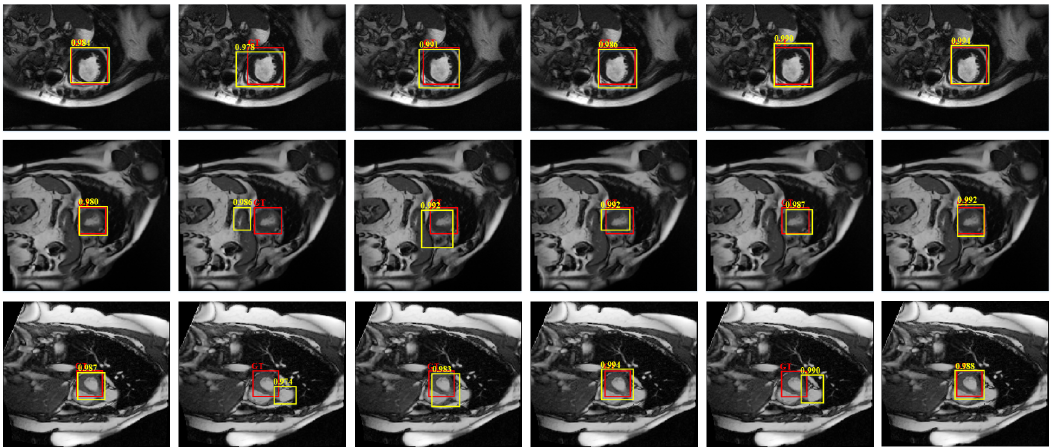
Figure 10. Examples of detection results, where red rectangles denote ground-truth and yellow ones denote results by compared methods. Each row from left to right: Our model; BCD; RCNN; Faster RCNN; YOLOv3, and RefineDet,